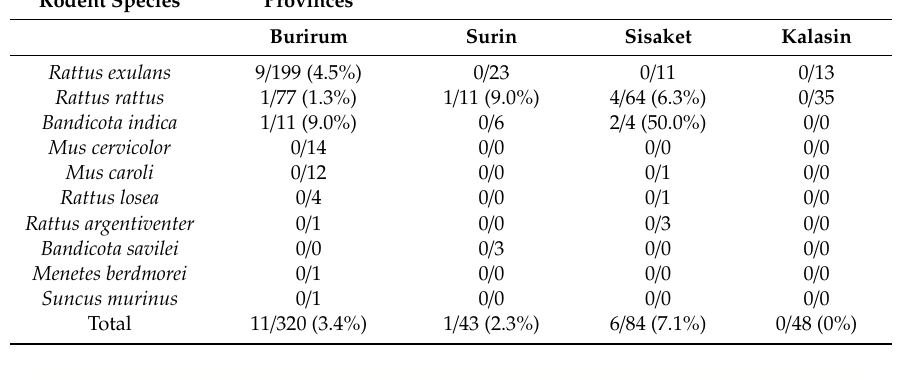
Table 2. Prevalence of Leptospira carriage in kidneys stratified by rodent species and provinces. Rodent